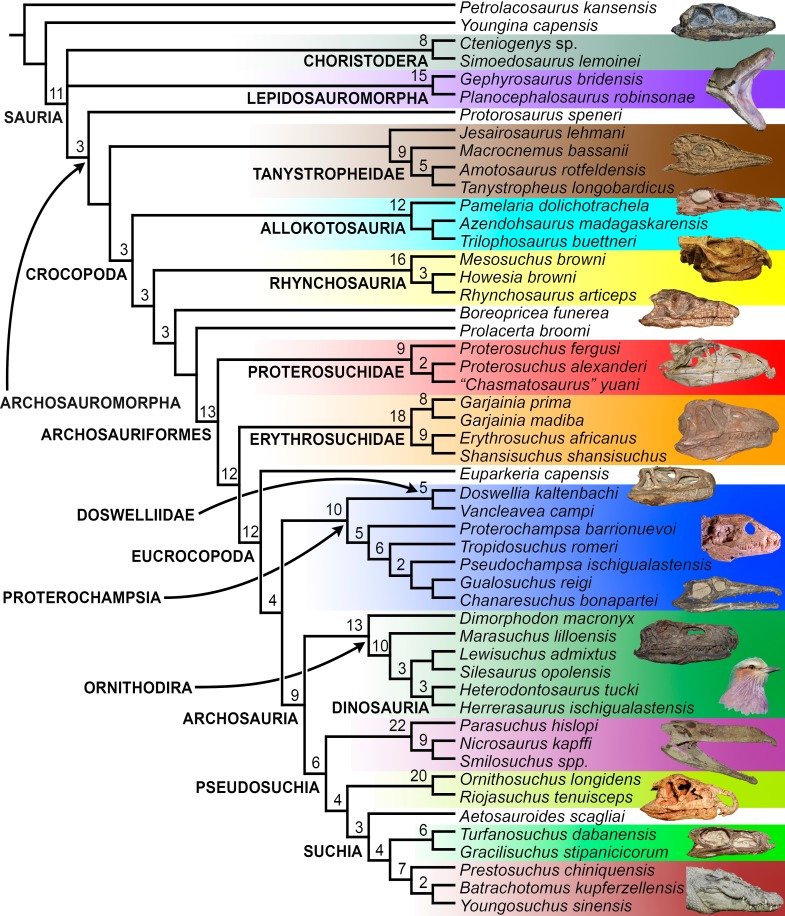
Bremer supports recovered after the pruning a posteriori of terminals with high amount of missing data in analysis 3.Photograph of the lepidosauromorph and the extant dinosaur courtesy of Mariana Grassetti and photograph of the allokotosaurian courtesy of Sterling Nesbitt.